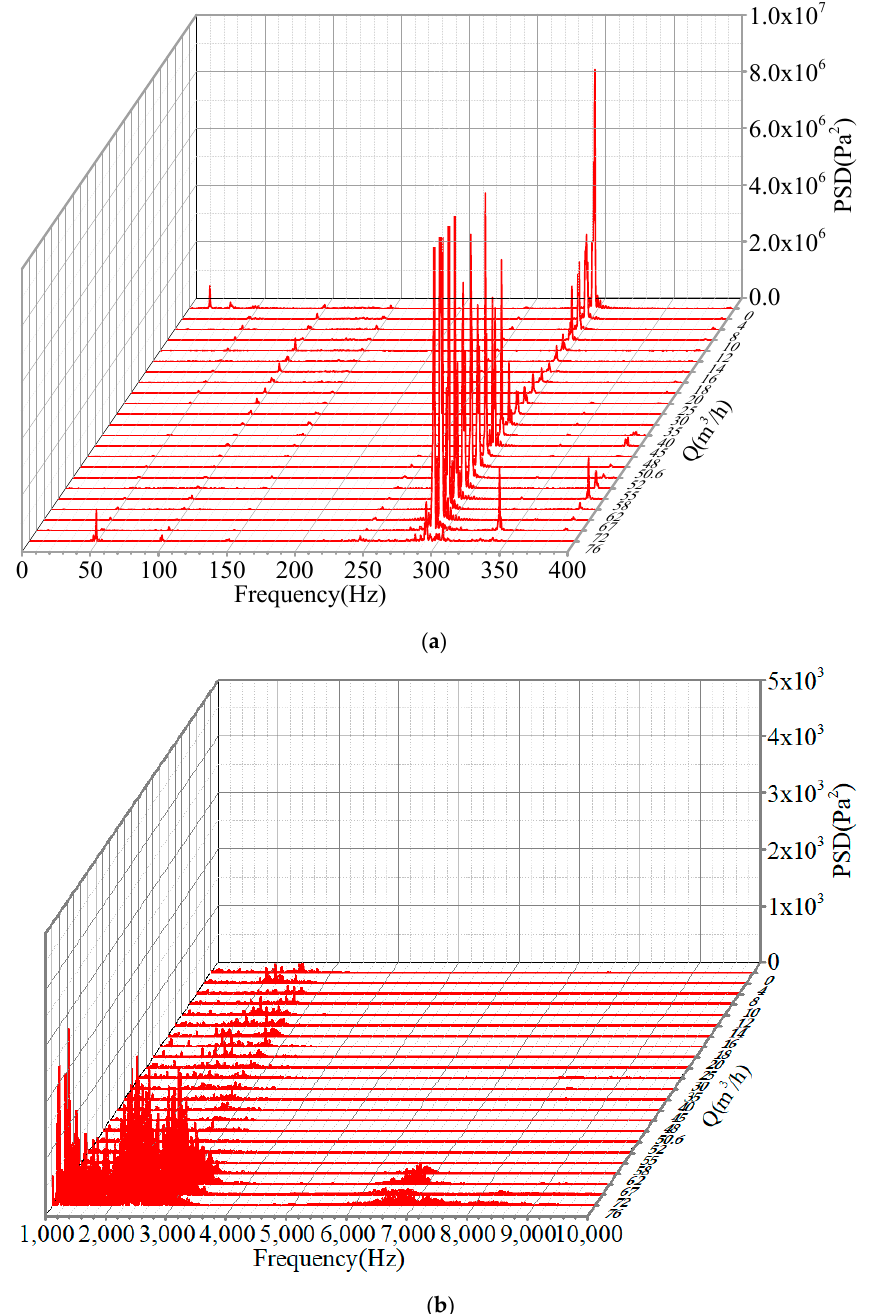
Figure 15. PSD of the acoustic pressure measured by pump inlet hydrophone 2 at different flow rates. ( a ) 0–400 Hz; ( b ) 1–10 kHz.